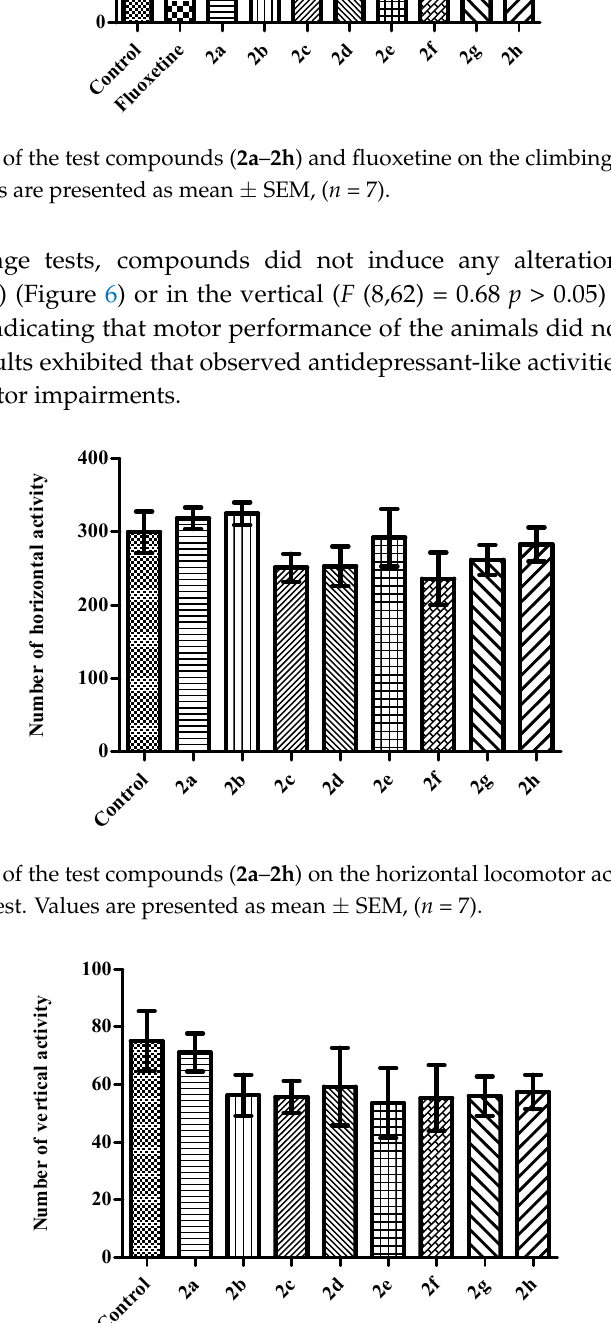
Figure 7. The effects of the test compounds ( 2a – 2h ) on the vertical locomotor activities of the mice in the activity cage test. Values are presented as mean ± SEM, ( n = 7).